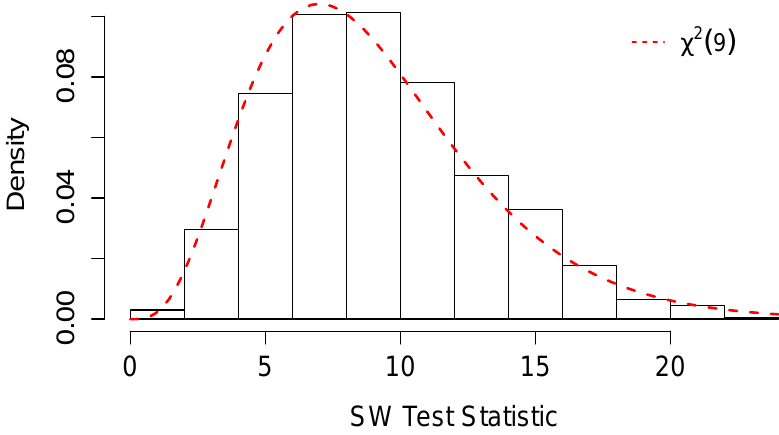
Figure 2. The empirical vs. asymptotic sampling distribution of SW by 1000 data cloning. Table 6. Model-II robust standard errors of FOSLS calculated by Theorem 1. θ